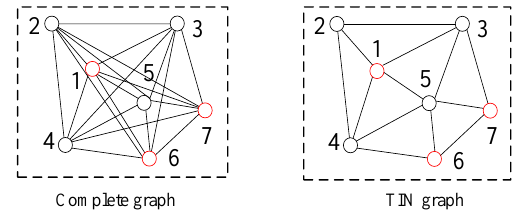
Figure 4. Comparison of the complete graph and TIN graph.